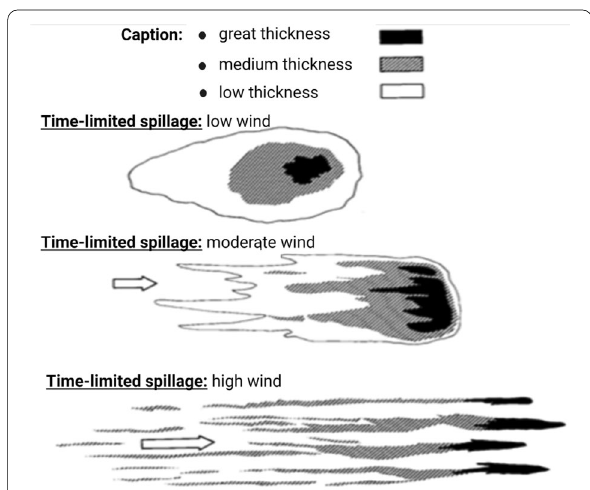
Fig. 9 Cedre’s field guide on dispersant application. The oil slick spreads rapidly towards the direction of wind and wave and affect the oil thickness. The thickest head located down-wind and oil slicks gradually get emulsified. The stronger the wind is, the faster the weathering process will be, which could even lead to very heterogeneous